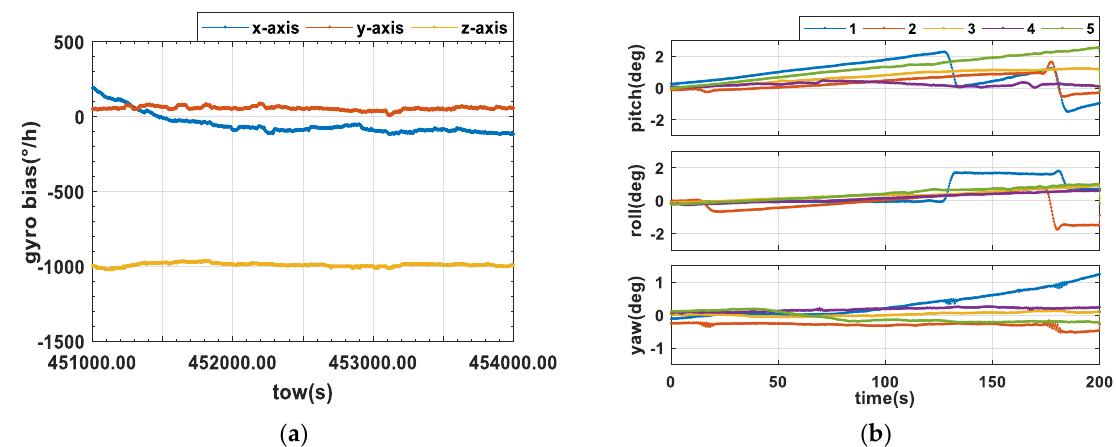
Figure 8. ( a ) MEMS gyro bias of each axis; ( b ) attitude drift of MEMS